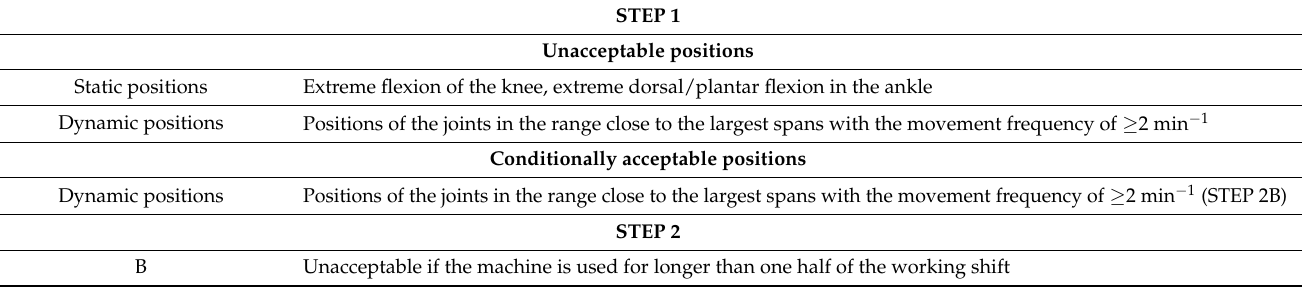
Table 8. Positions of the lower limbs [9].